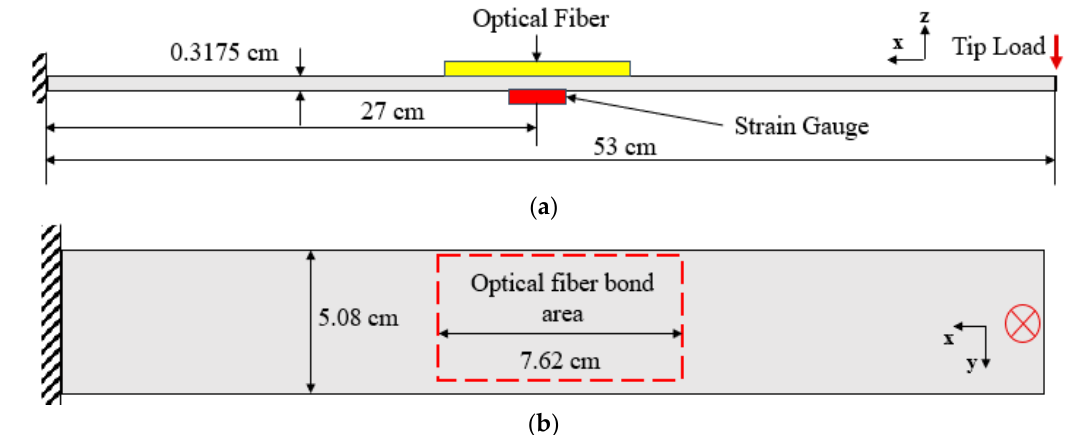
Figure 2. ( a ) Side view of cantilever beam and ( b ) top-down view of cantilever beam.